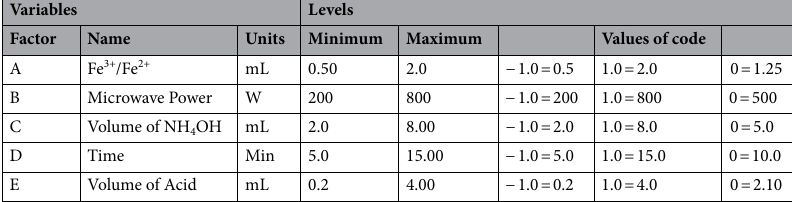
Table 1. Variable levels for RSM experiment. RSM, response surface methodology; Fe 3+ /Fe 2+ , iron (III)/iron (II); NH 4 OH, ammonium